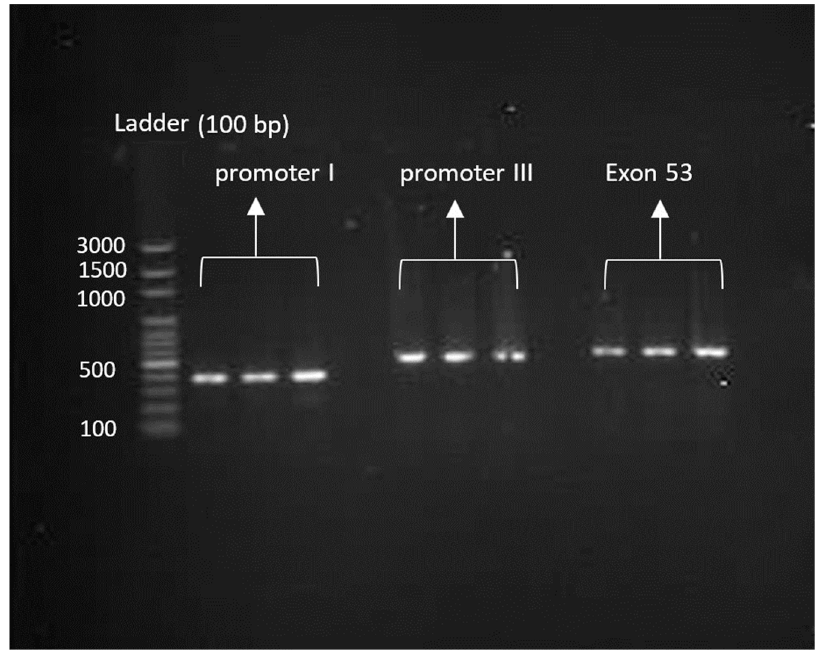
Figure 1. PCR products of ACAC α gene of Najdi sheep in 2% gel electrophoresis agarose (PI: pro- moter I; PIII: promoter III, and E53: Exon 53). I; PIII: promoter III, and E53: Exon